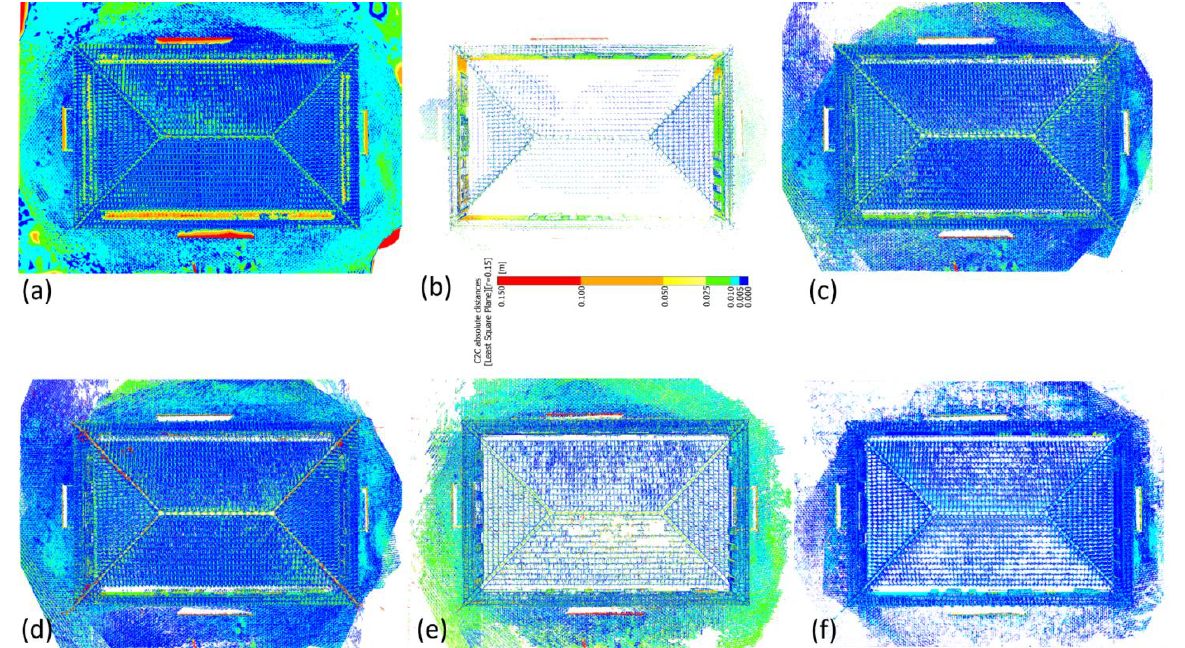
Figure A7. Comparison of TLS and image-based point clouds of the test object (top view): ( a ) Con- textCapture; ( b ) GRAPHOS; ( c ) Metashape; ( d ) PhotoScan; ( e ) Pix4DMapper; ( f ) RealityCapture.